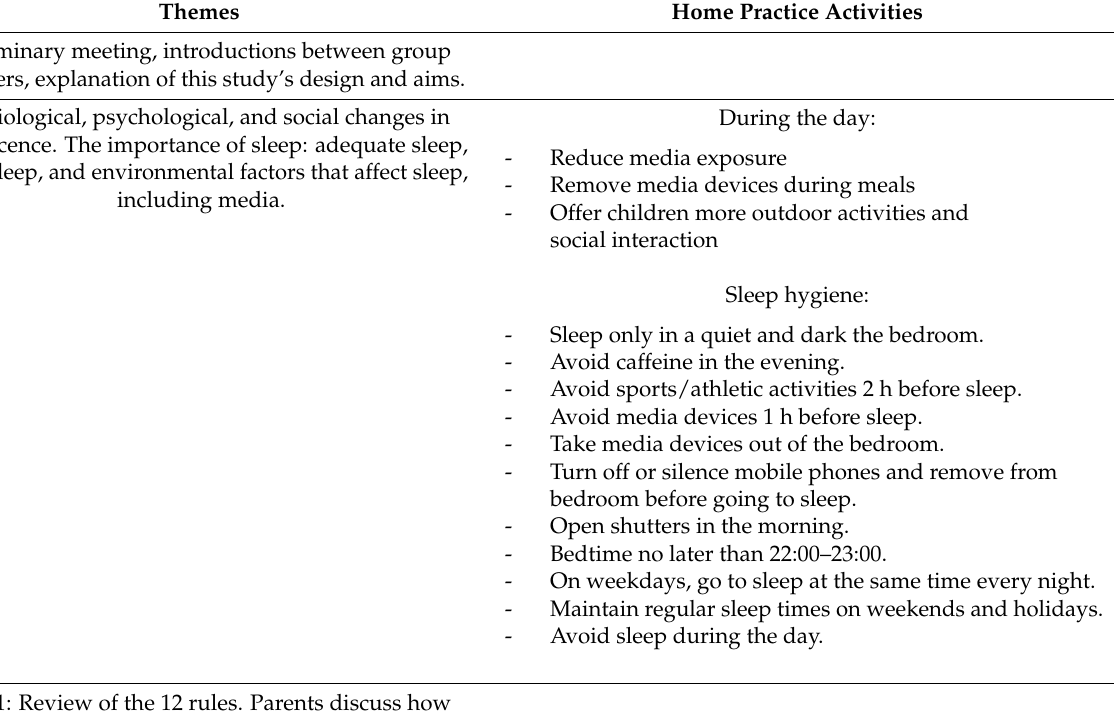
Table 3. Thematic intervention